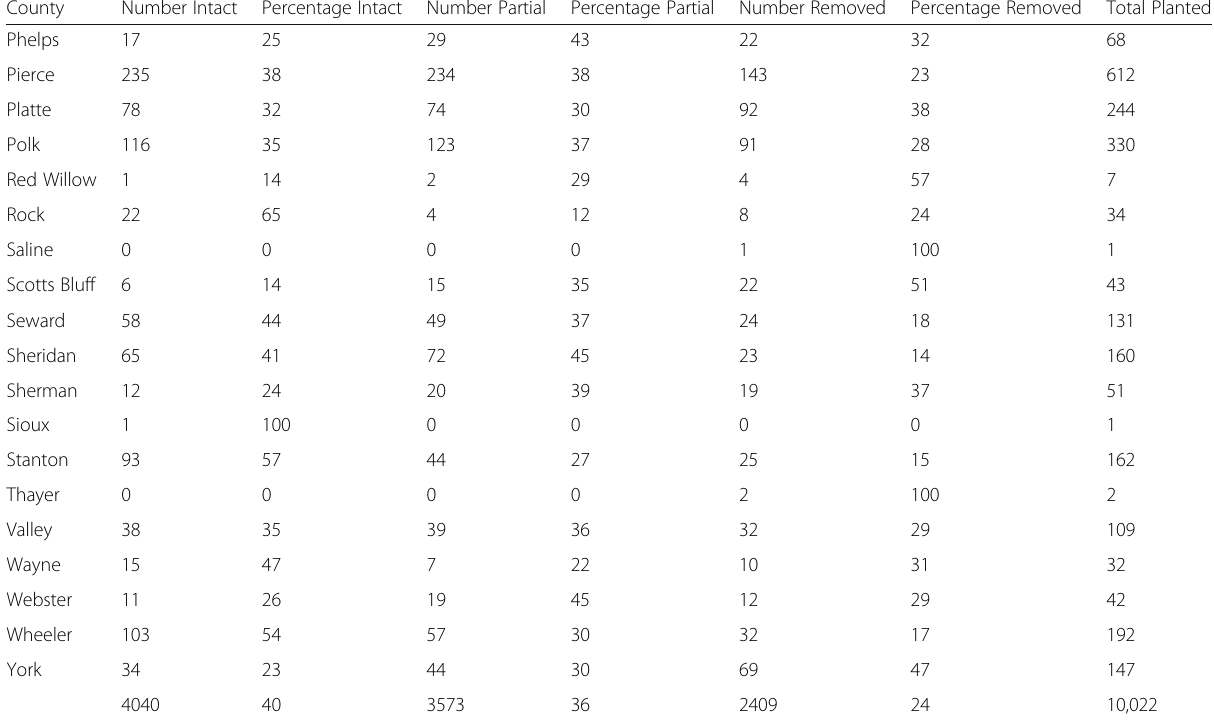
Table 5 2016 inventory and existing condition of Nebraska PSFP (1935 – 1942) in each participating county listed in alphabetical order (Continued)